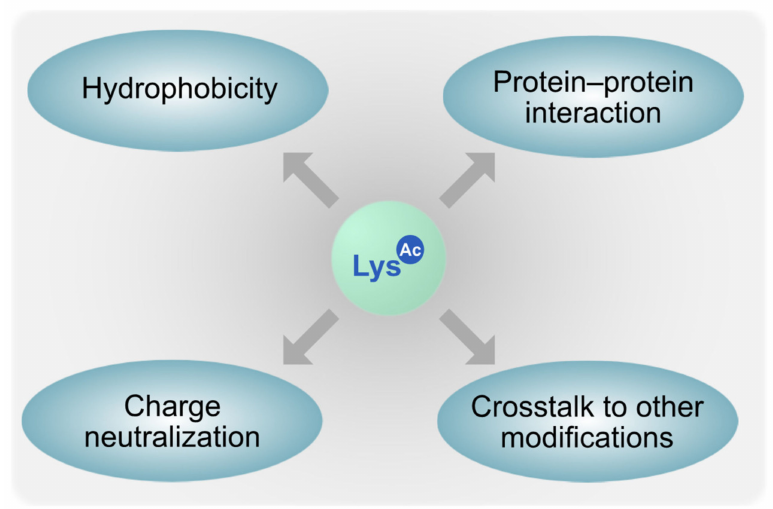
Figure 2. Possible biochemical consequences of lysine